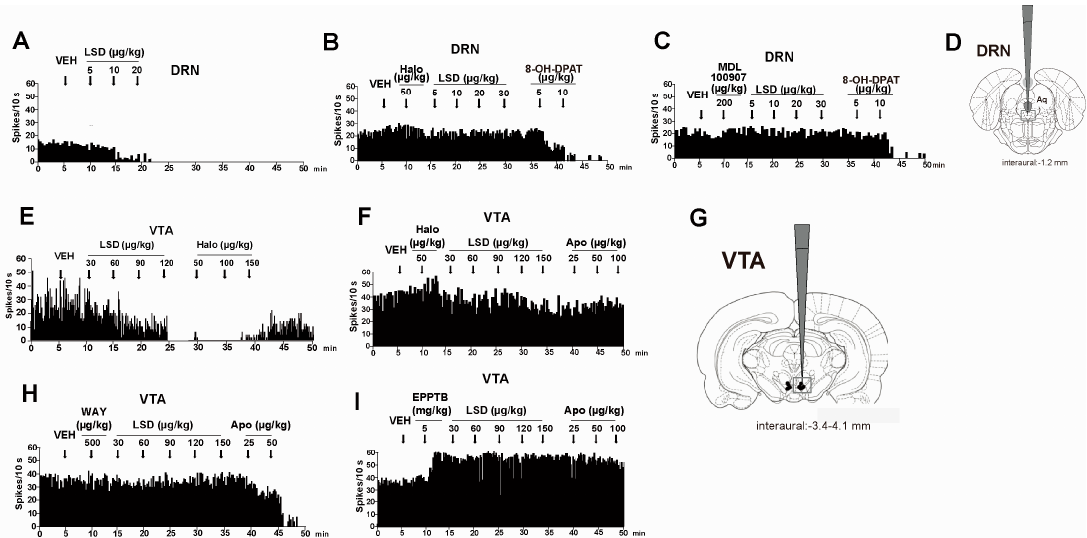
Figure 2. Representative integrated firing rate histograms showing the effects of intravenous LSD administration on the firing rate of dorsal raphe nucleus (DRN) serotonin (5-HT) neurons and of ventral tegmental area (VTA) dopamine (DA) neurons (modified from De Gregorio et al. 2016, with permission [115]): ( A ) LSD (5–20 µg/kg) decreases DRN 5-HT neurons; ( B ) Haloperidol (halo, 50 µg/kg); and ( C ) MDL 100 907 (200 µg/kg) prevent the inhibitory effect of LSD on DRN 5-HT neurons; ( D ) illustration portrays a coronal brain section (Paxinos and Watson, 1986 [117]) containing the DRN, the boxed area encompassing the DR represents the location where most putative 5-HT neurons were found; ( E ) LSD (30–120 µg/kg) decreased VTA DA neurons: ( F ) Haloperidol (halo, 50 µg/kg) prevents the inhibitory effect of LSD on VTA DA neurons ( G ) illustration portrays a coronal brain section (Paxinos and Watson, 1986) containing the VTA; ( H ) WAY 100 907 (WAY, 200 µg/kg); and ( I ) EPPTB (5 mg/kg) prevent the inhibitory effect of LSD on VTA DA neurons.